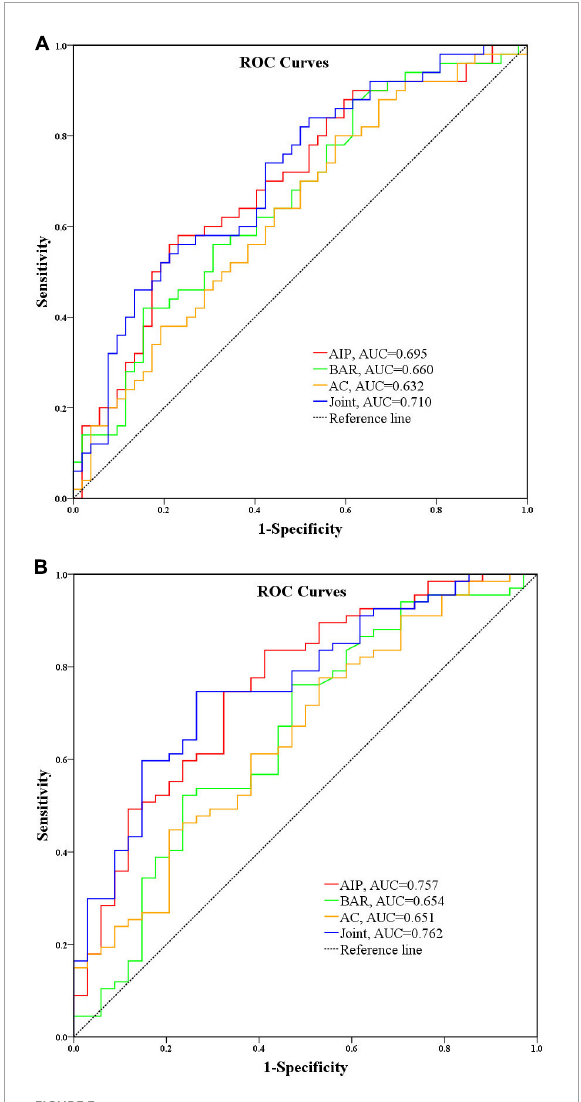
FIGURE3 (A) Predictive performance analysis of AIP, BAR, and AC for overweight. (B) Predictive performance analysis of AIP, BAR, and AC for central